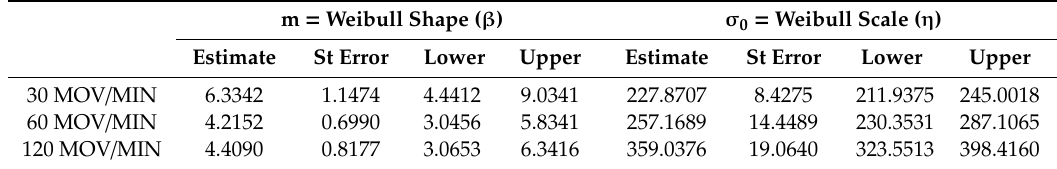
Table 6. Weibull statistics of the number of cycles of in-and-out